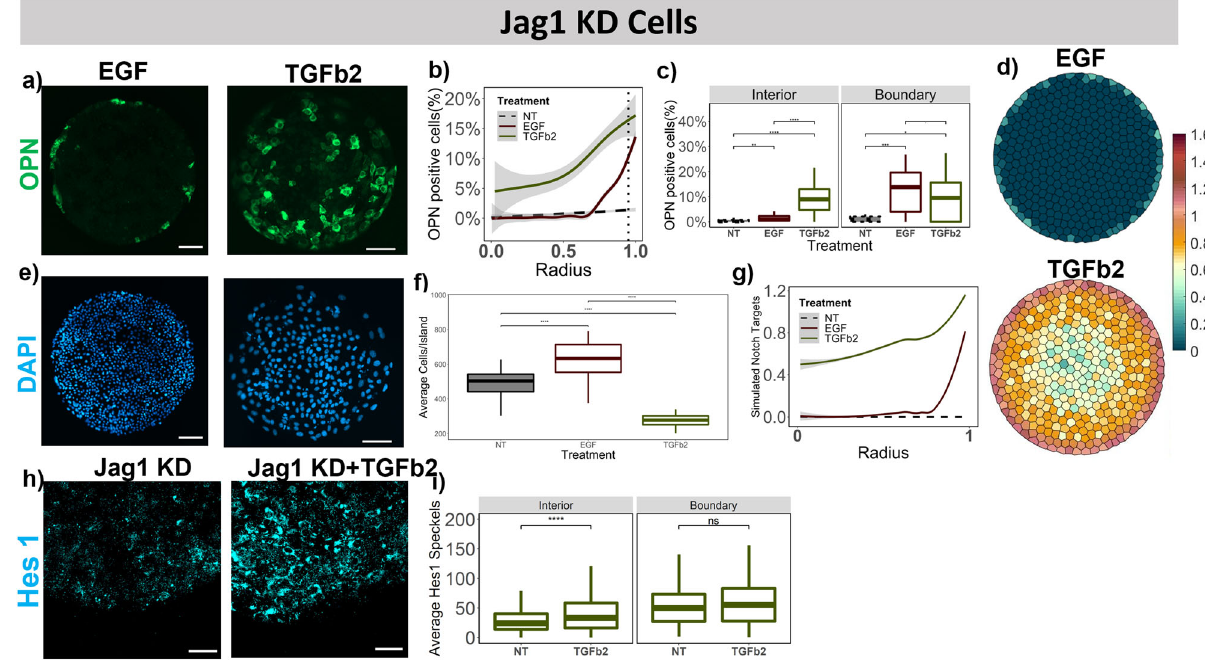
Fig. 7 Effect of extrinsic growth factor treatments in conjunction with Jag1 knockdowns. a Representative fl uorescent Images of EGF and TGF β 2 treated Jag1 KD BMELs on Col 1 microarrays on 25 kPa polyacrylamide hydrogels. Green: OPN, Blue: DAPI. Scale Bar: 100 μ m. b Quanti fi cation of average percent OPN + cells/island as a function of the radius. 0 is center, 1 is the edge, vertical dashed line at radius = 0.95. c Quanti fi cation of average percent OPN + cells/island in the interior (radius = 0 – 0.95) and at the boundary (radius = 0.95 – 1.00). e DAPI fl uorescent Images for EGF and TGF β 2 treated Jag1 KD BMELs on circular microarrays. Scale Bar: 100 μ m. f Quanti fi cation of Average Cell Number per individual island for EGF and TGF β 2 treated Jag1 KD BMELs. d Simulated Notch target genes on cells on a circular lattice, with in silico growth factor treatments and Jag1 KD. Heatmap color: arbitrary unit for Notch target genes. g Quanti fi cation of simulated Notch target genes in cells on a circular lattice for the in silico growth factor treatments and Jag1 KD. h ISH-HCR quanti fi cation of Hes1 mRNA, 40X confocal maximum intensity projection of Jag1 KD BMELs with and without TGF β 2 on circular islands. i Quanti fi cation of average Hes1 mRNA speckles for images in 6p on the boundary versus the interior. Boxplots- ‘ . ’ : ns; * p -value < 0.05; ** p -value < 0.01; *** p -value < 0.001 **** p -value < 0.0001, calculated using Wilcox test in R. Line plots — Gray: 95% con fi dence interval. n ≥ 4 biological replicates (independent experiments) and n ≥ 15 technical replicates (individual islands). The No Treatment Control (NT) for the Jag1 KD BMELs is referred from Fig. 3b, c for statistical